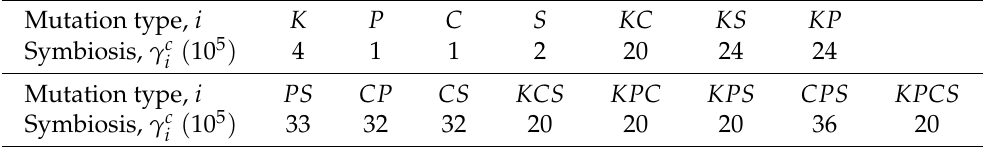
Table 3. Estimates of the effect of symbiosis between healthy cells and cancerous and precancerous cells of type i